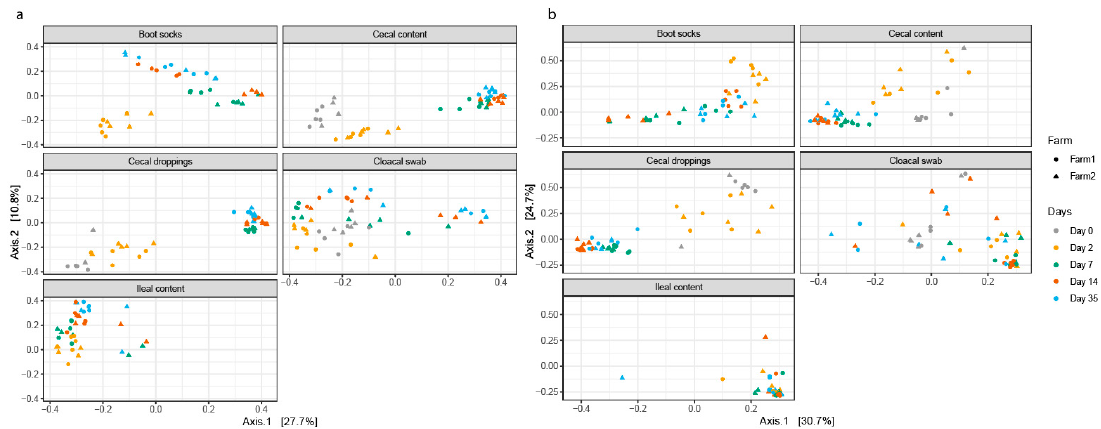
Figure 2. Principal coordinate plots (PCoA) based on ( a ) unweighted UniFrac and ( b ) weighted UniFrac distances between cecal and ileal content, cloacal swabs, cecal droppings and boot socks. Different sample types are shown in separate plots for clarity (Combined Figure S3). Different colors indicate different sampling days, circles are samples of Farm 1 and triangles are samples of Farm 2.